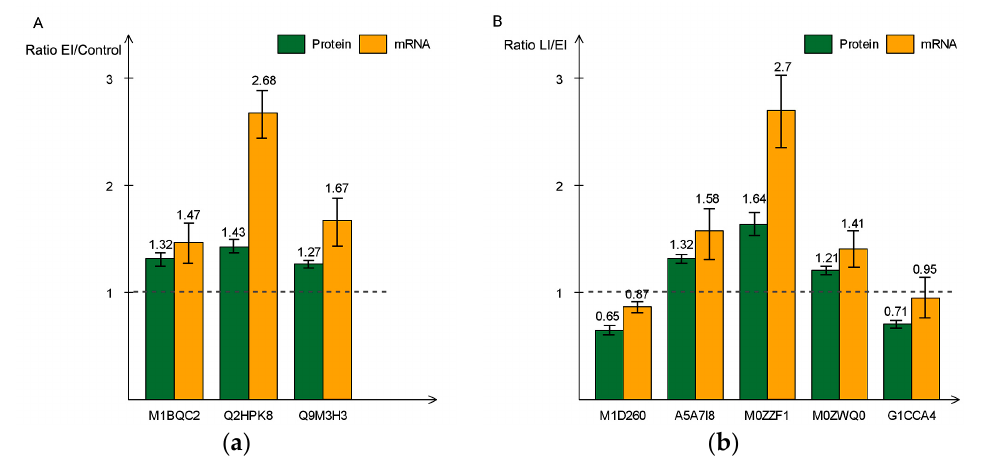
Figure 8. Real-time polymerase chain reaction (PCR) quantitative analysis of eight differentially-expressed proteins and mRNA at early ( a ) and late ( b ) disease stages. The green bar indicates the expression level determined by Tandem mass tag (TMT) and orange bar shows relate expression of mRNA. All data are presented as mean ± SD ( n = 3 in each time-point).